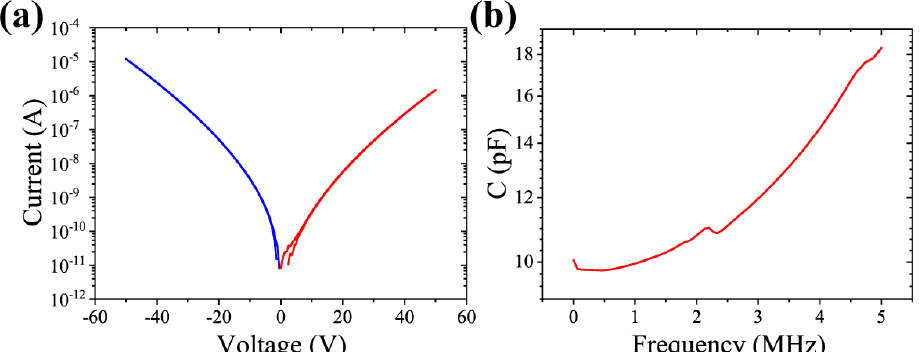
Figure 5. Al 0.7 Sc 0.3 N with Pt as the bottom electrode. ( a ) I − V curve with voltage scanning from 0 V to 50 V and then returning to 0 V, similar in the negative direction. ( b ) The C − F scan goes from 1 kHz to 5 MHz and